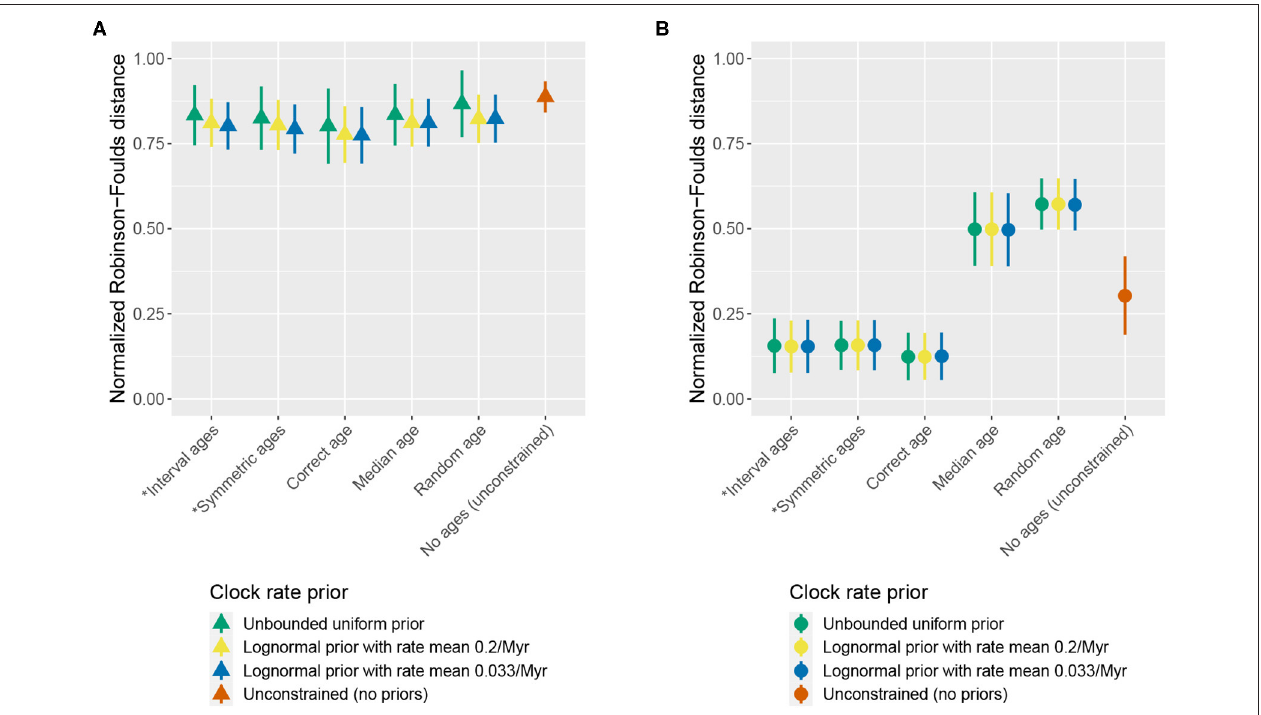
FIGURE 2 | Impact of the clock prior on topology. The mean and standard deviation of the normalized Robinson-Foulds distance between the true simulated tree and trees inferred during MCMC across all replicates are shown for different clock rate priors, different age handling methods, and different fossil sampling settings [low (A) vs. high (B) ]. Ages sampled as part of the MCMC are marked by (*). (A) Low fossil sampling and character length 30. (B) High fossil sampling and character length